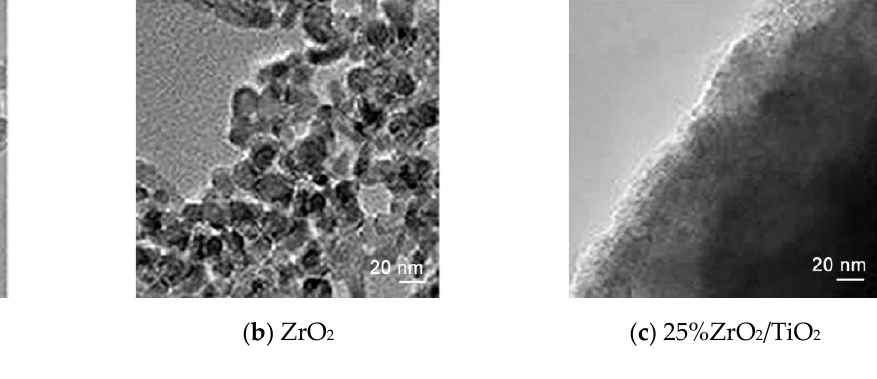
Figure 2. TEM images of samples.